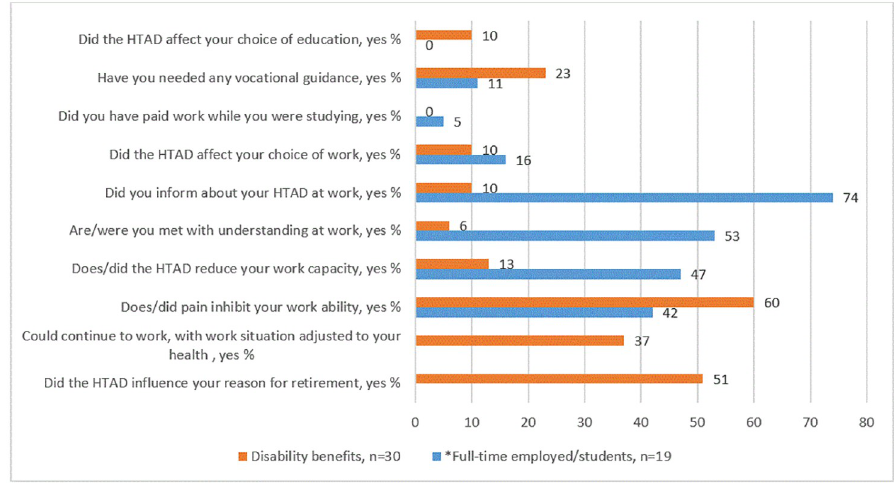
Fig 5. Self-reported work challenges and work adjustments according to employment status. � One